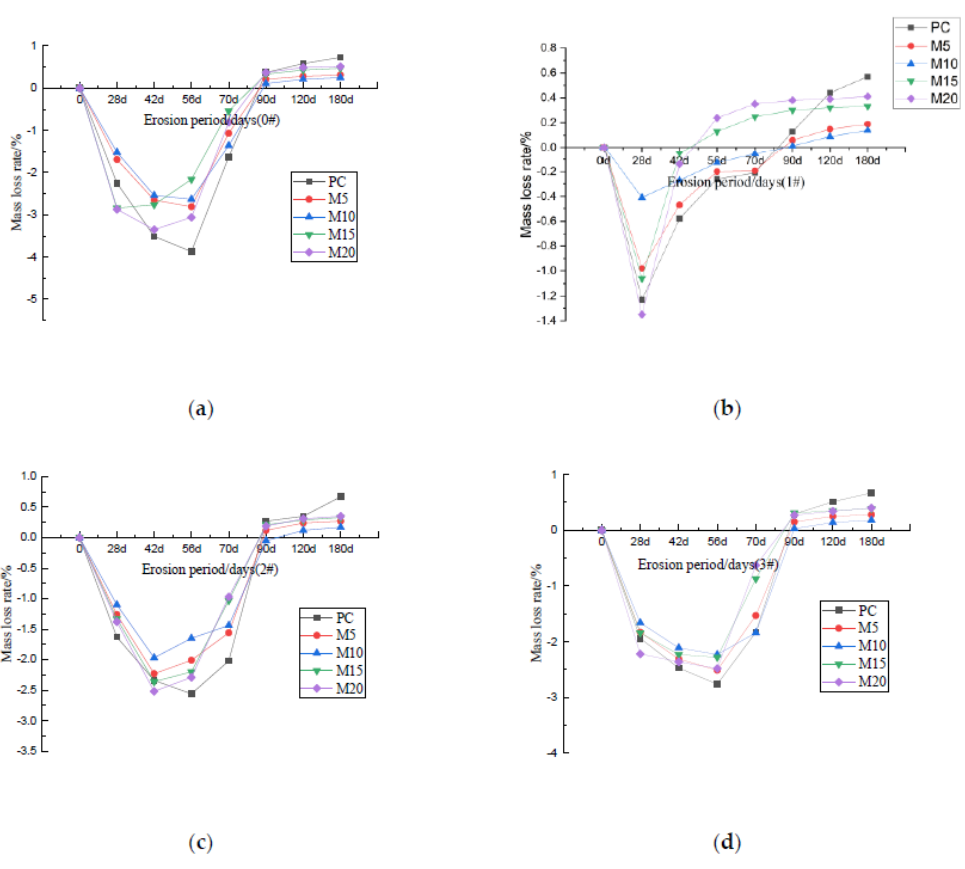
Figure 6. The mass loss rate of cement after a different erosion period under different curing methods; ( a ) 0#, ( b ) 1#, ( c ) 2#, ( d ) 3#.